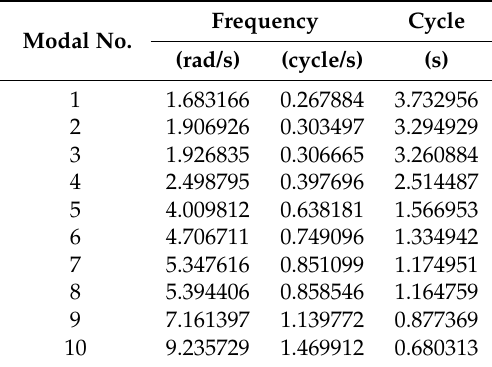
Table 1. The first ten order modal frequency of upper structure of H-Q RB.